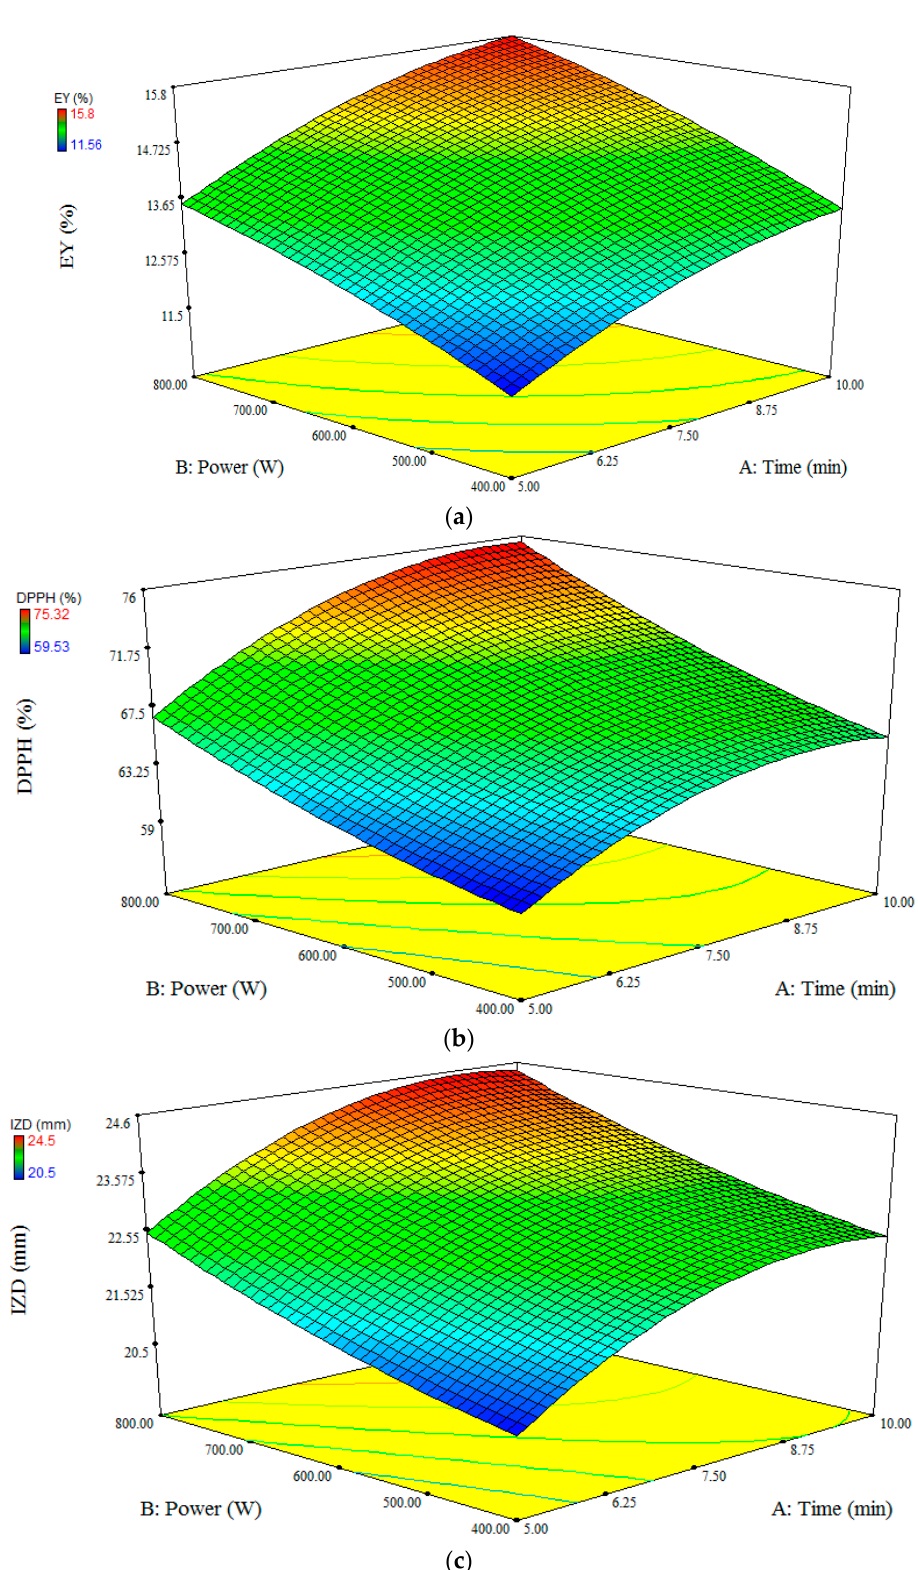
Figure 1. The surface response plot of the interactions of power and time on extraction yield (EY, ( a )), inhibition zone diameter (IZD, ( b )), and antioxidant activities (DPPH, ( c )) of SBL extract obtained by microwave-assisted extraction method.